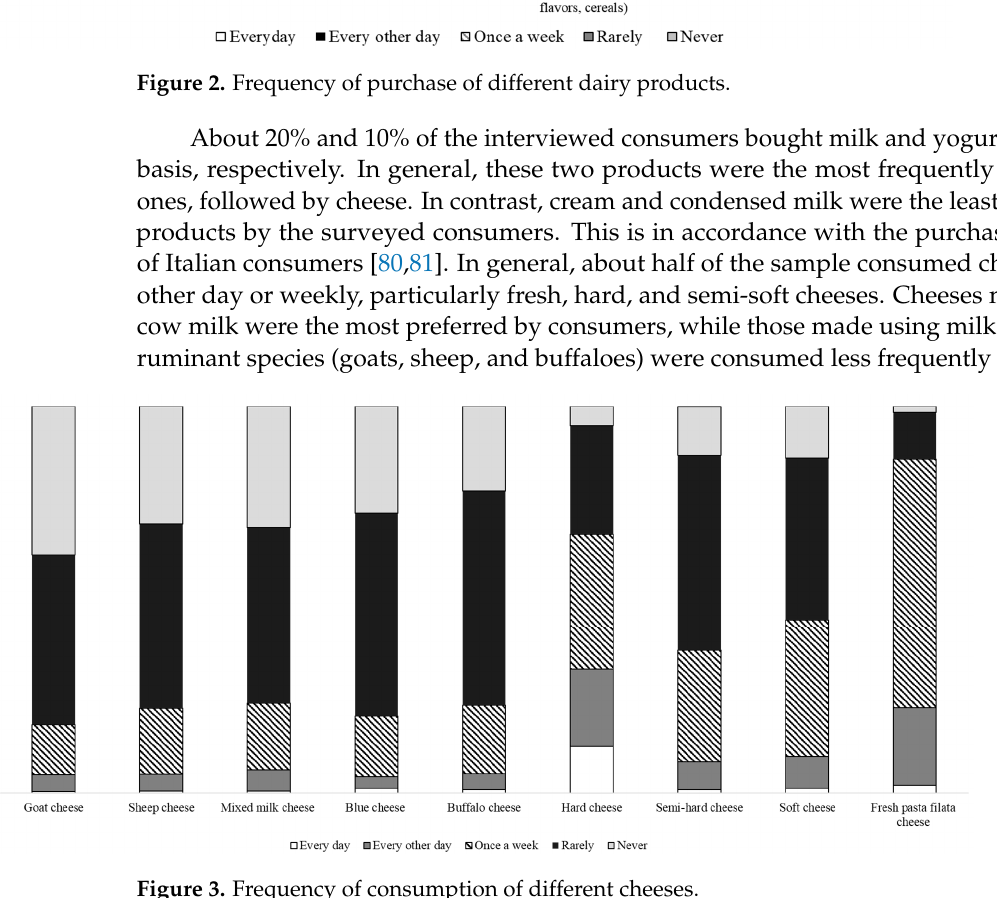
Figure 3. Frequency of consumption of different cheeses.